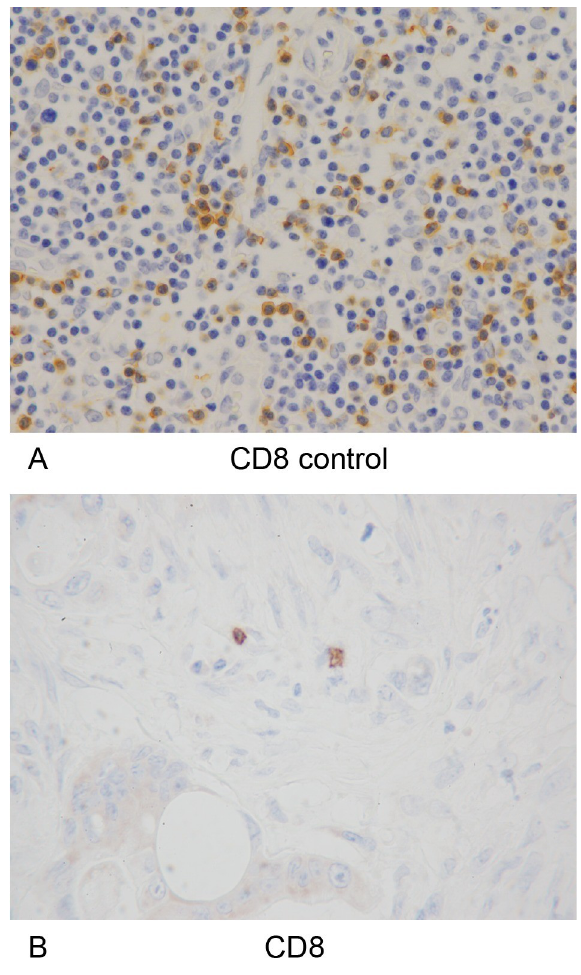
(x400 HPF). (B) Immunohistochemical detection of CD8-positive tumor-infiltrating lymphocytes (x400 HPF).